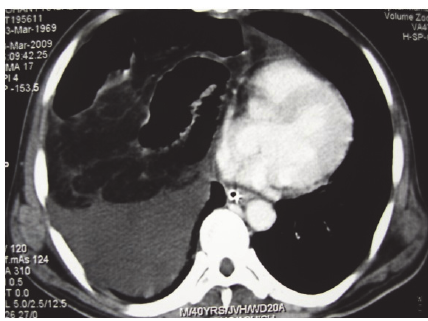
Figure 2: Preoperative CT scan showing thickened small bowel loops in the right hemithorax with air specks in the bowel wall suggesting a strangulated diaphragmatic hernia.